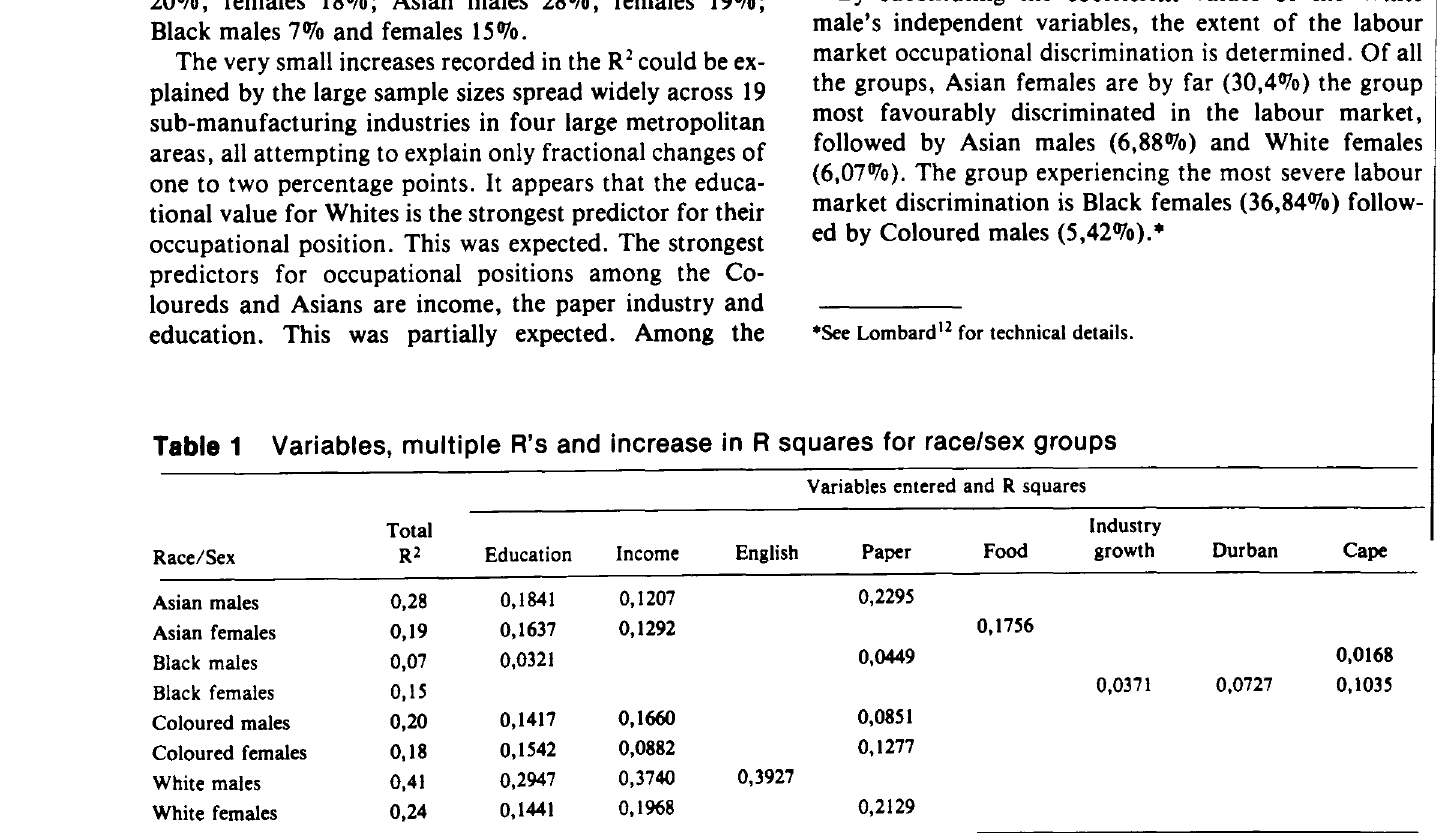
Variables entered and R